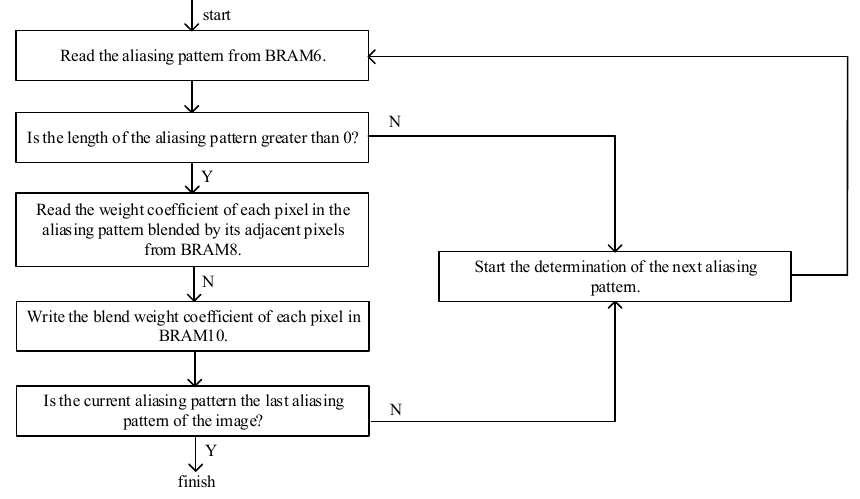
Figure 11. Flow diagram of the module Get_Blend_Weights